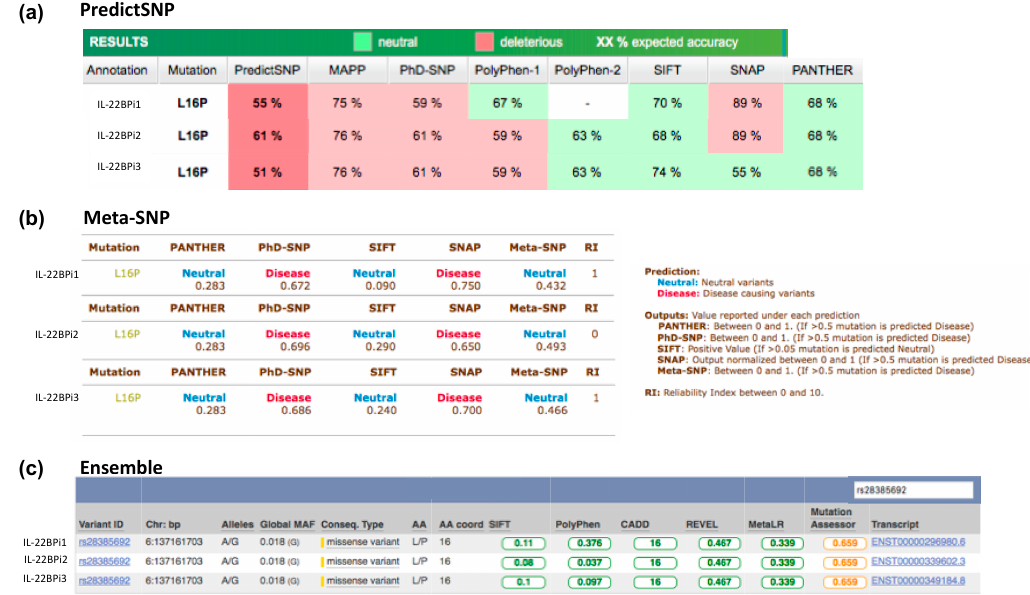
Figure A3. The pathogenicity prediction of rs28385692 using PredictSNP ( a ), Meta-SNP ( b ), and ( c ) Ensemble VEP web servers. The results indicate the predictive severity of the p.Leu16Pro variant conferred by the SNP rs28385692 for the three IL-22BP isoforms.